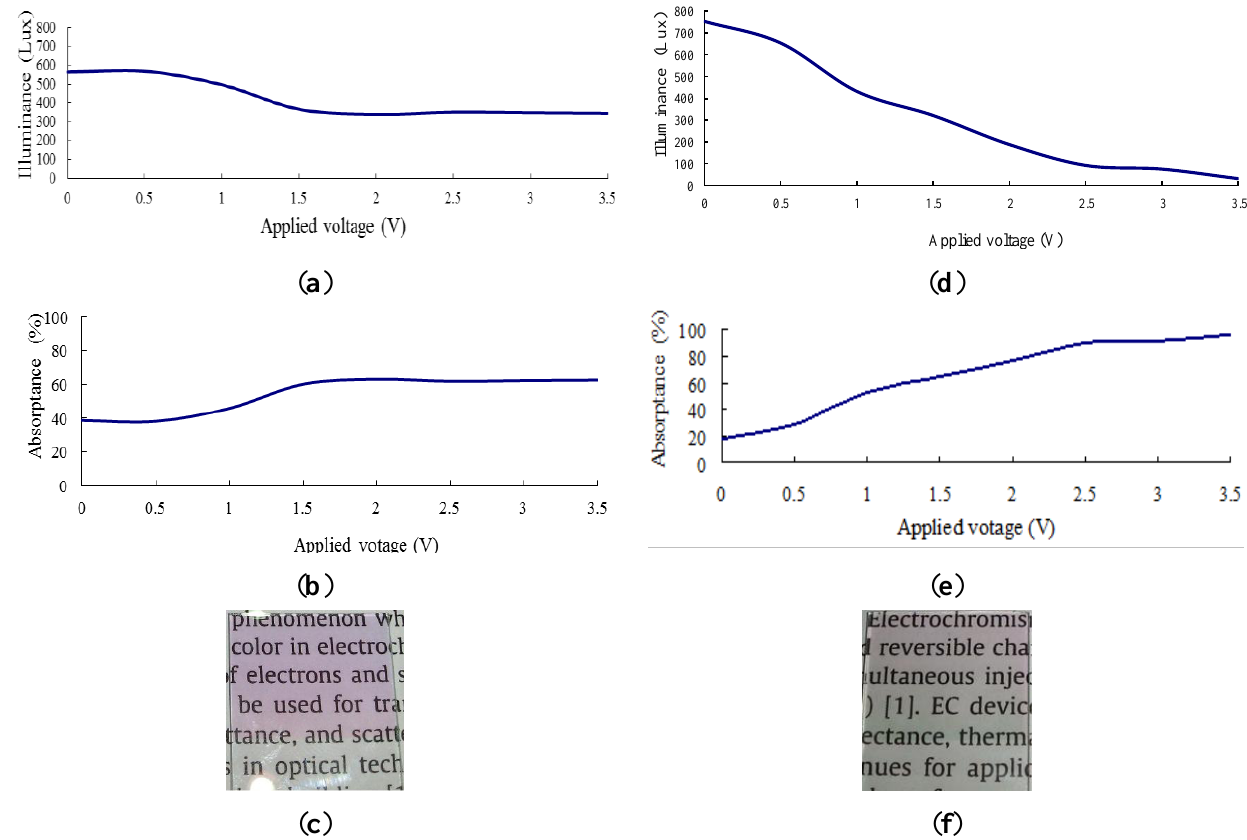
/Ta O /ITO EC 3 2 5